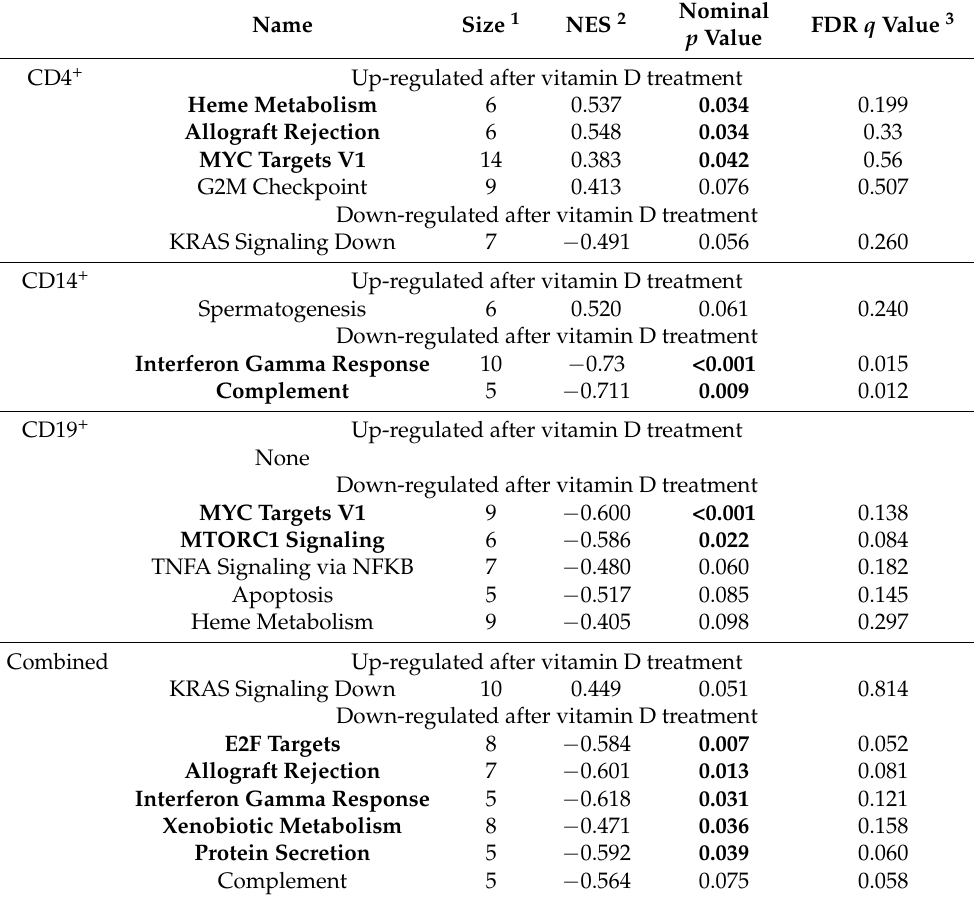
Table 2. Significantly up- or down-regulated gene sets from gene set enrichment analysis (nominal p value <